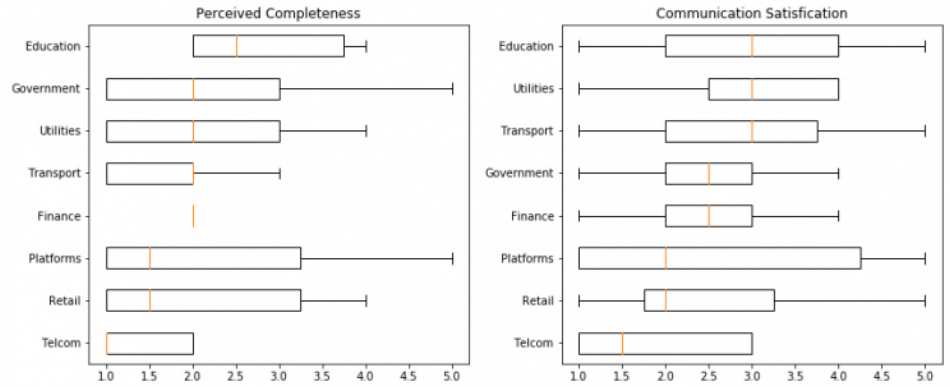
Figure 3: Perceived completeness (left) & Communication satisfaction (right) grades given by participants to access responses (Boxplots are ordered by the median grade per sector, indicated by the orange line in the rectangles. The rectangles show the 25 and 75 percentiles of grades, which are on a Likert